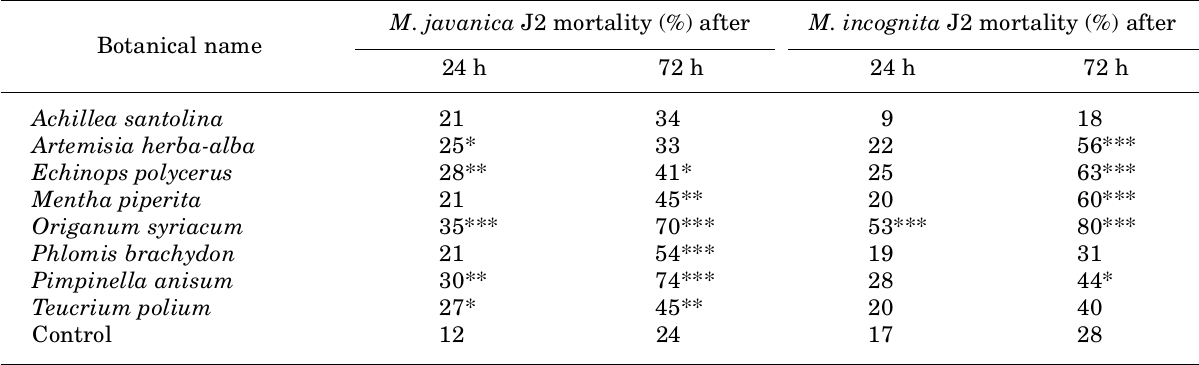
Table 3. Effect of eight plant extracts (200 µ g ml -1 ) on mortality of second stage juveniles (J2s) of Meloidogyne javanica and M. incognita .